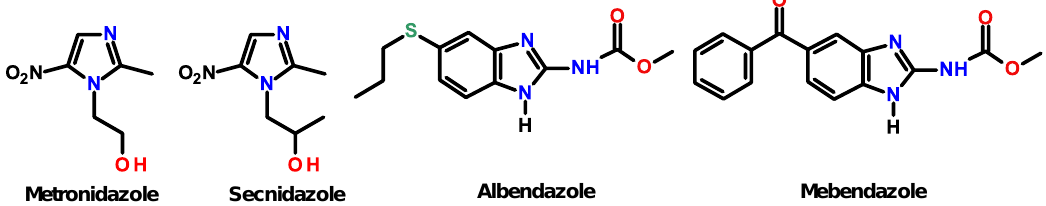
Figure 1. Most common antiprotozoal 5-nitroimidazole and benzimidazole methylcarbamate drugs of choice.